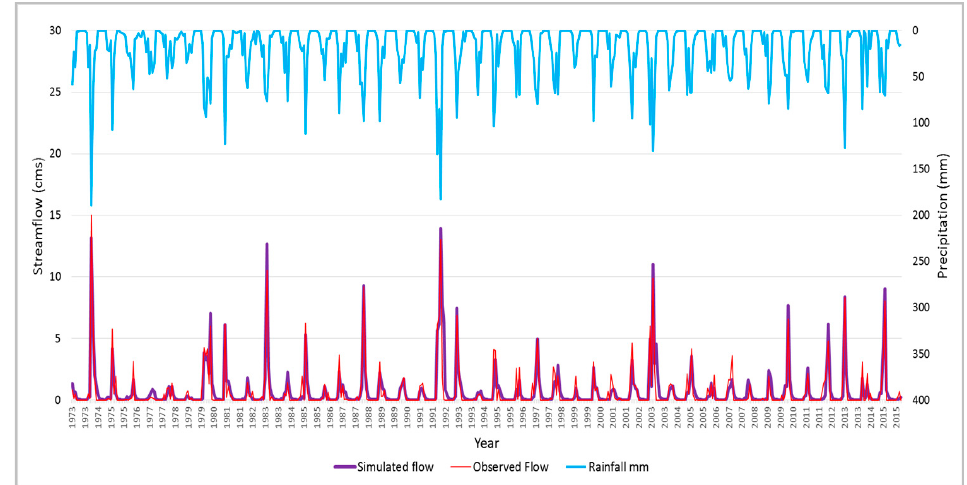
Figure 5. Comparison between measured and simulated monthly flood discharge for AZB at Jerash Bridge gauging station (AL0060) after manual calibration.